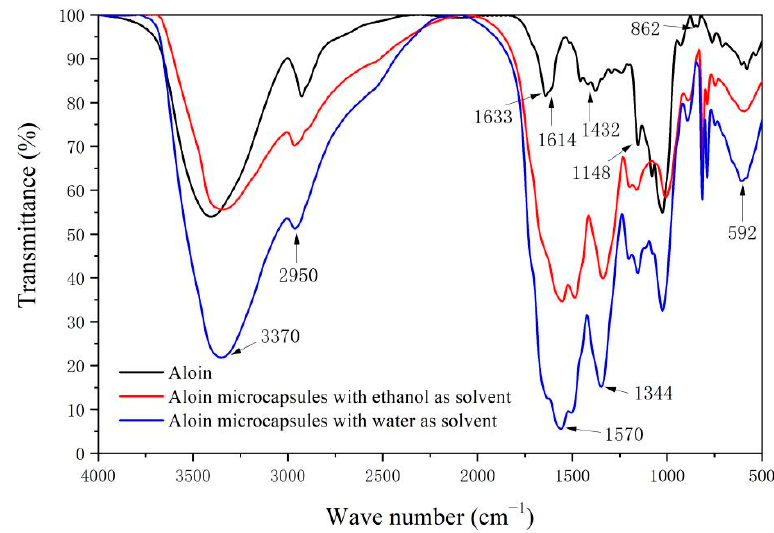
Figure 3. Infrared spectrum of the aloin, the aloin microcapsules prepared with ethanol as the solvent, and the aloin microcapsules prepared with water as the solvent.